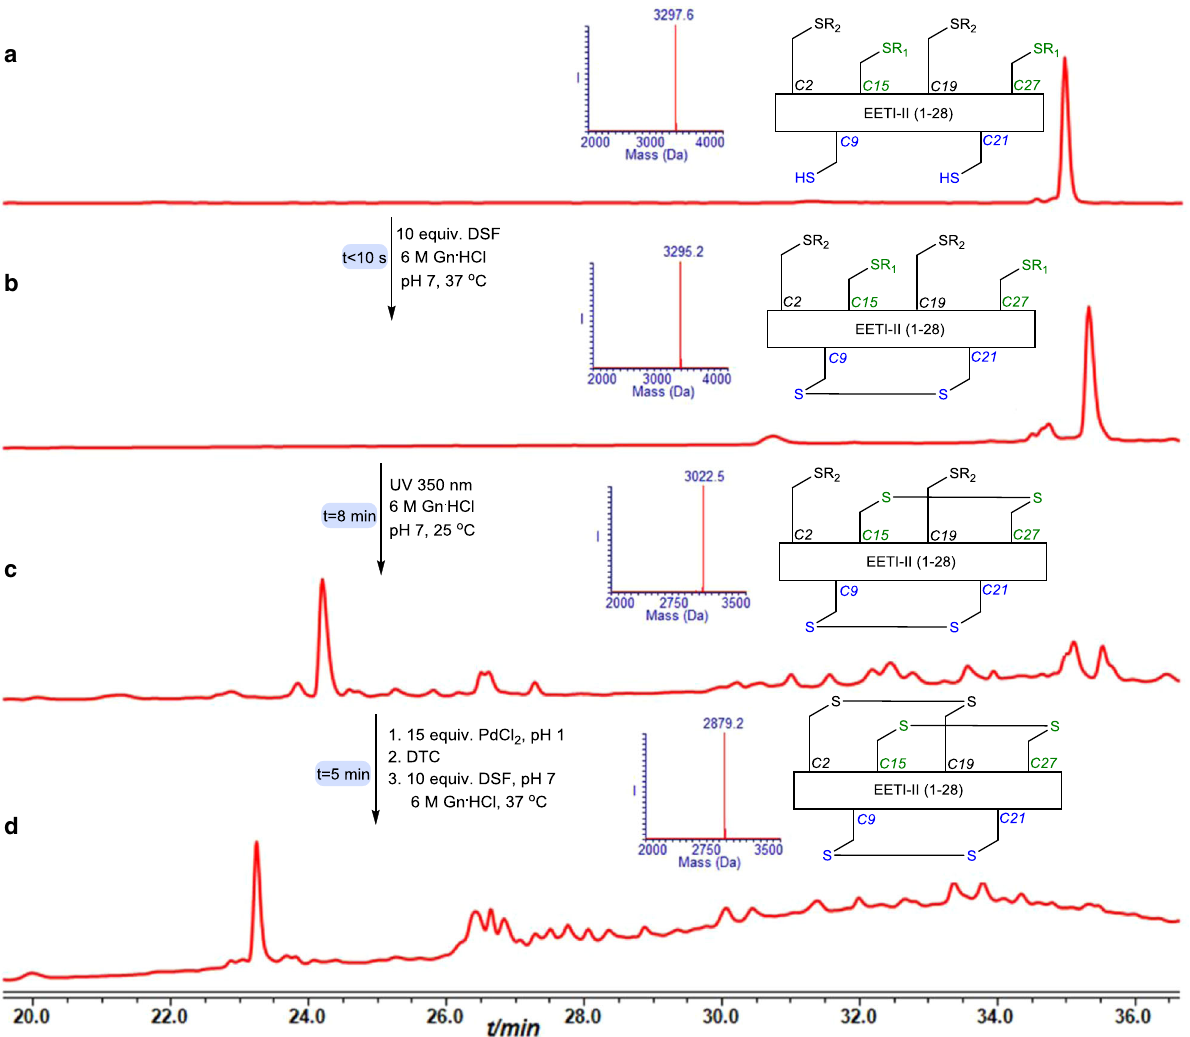
Fig. 6 EETI-II synthesis. a HPLC-ESI MS analyses: Reaction at time zero, the main peak corresponds to reduced EETI-II with the observed mass 3297.6 ± 0.1 Da, calcd. 3297.4 Da (average isotopes). b Reaction after 10 s, the main peak corresponds to EETI-II with single disul fi de bond with the observed mass 3295.2 ± 0.1 Da, calcd. 3295.4 Da (average isotopes). c Reaction after 8 min: the main peak corresponds to EETI-II with two disul fi de bonds with the observed mass 3022.5 ± 0.2 Da, calcd. 3023.4 Da (average isotopes). d Reaction after 13 min: the main peak corresponds to EETI-II with three disul fi de bonds with the observed mass 2879.2± 0.1 Da, calcd. 2879.4Da (average isotopes). R 1 = NBzl, R 2 =